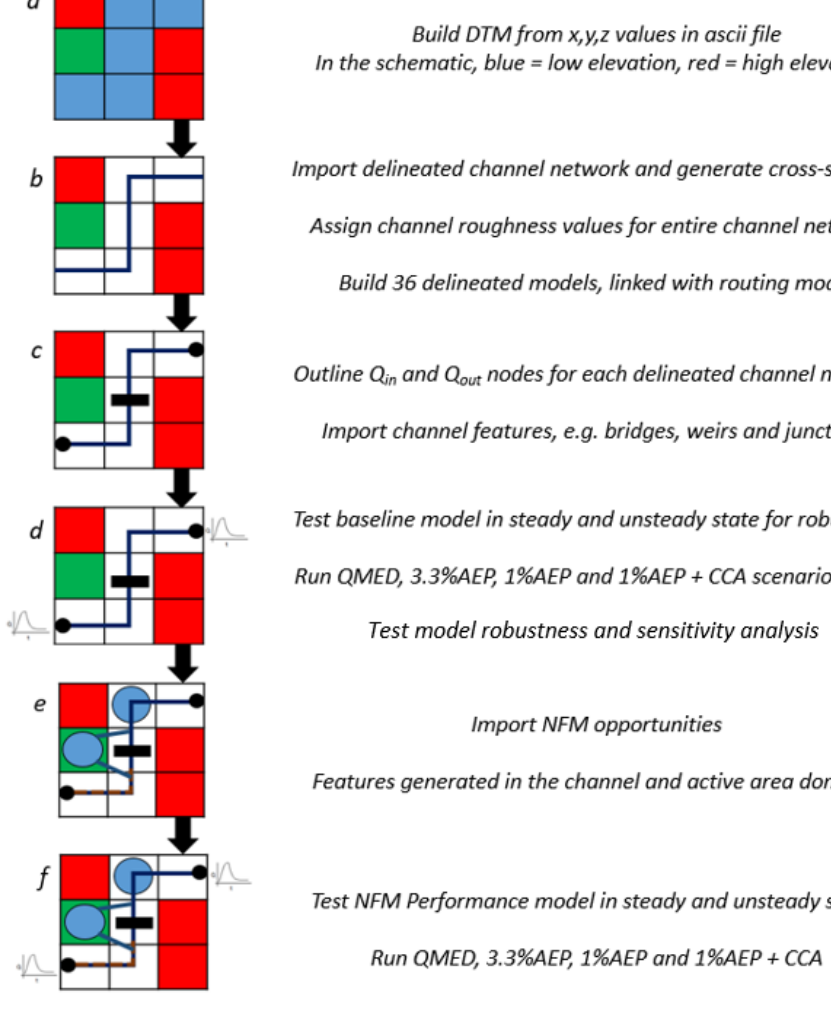
Figure 3. Model build schematic example for one of the sub-catchment models. Coloured squares represent elevation, blue (low)—green (middle)—red (high). Blue circles conceptually represent NFM features, and the black line across the channel is an in-channel feature (e.g.,